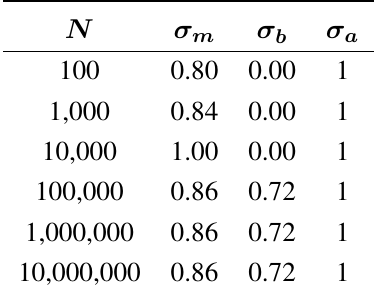
Table 5. Speeds for different number of tasks. ρ = 0.5, MTBF = 5 years, W = 1 h, t t = 2.6 R 2